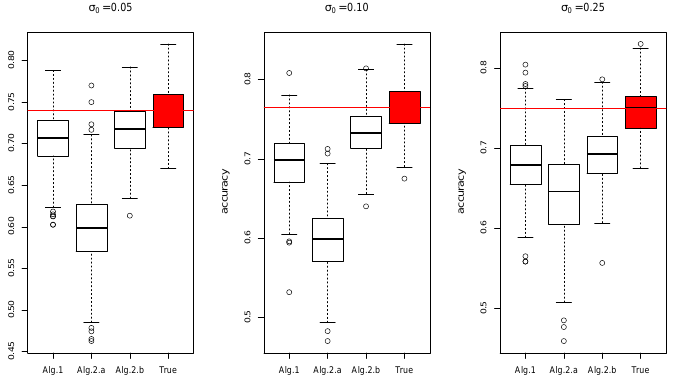
Figure 5. Total accuracy for the three Algorithms 1 and 2 under study at σ 0 = 0.05 ( top ), σ 0 = 0.10 ( middle ) and σ 0 = 0.25 ( bottom ). The boxplots on the right (in red) correspond to the theoreti- cal